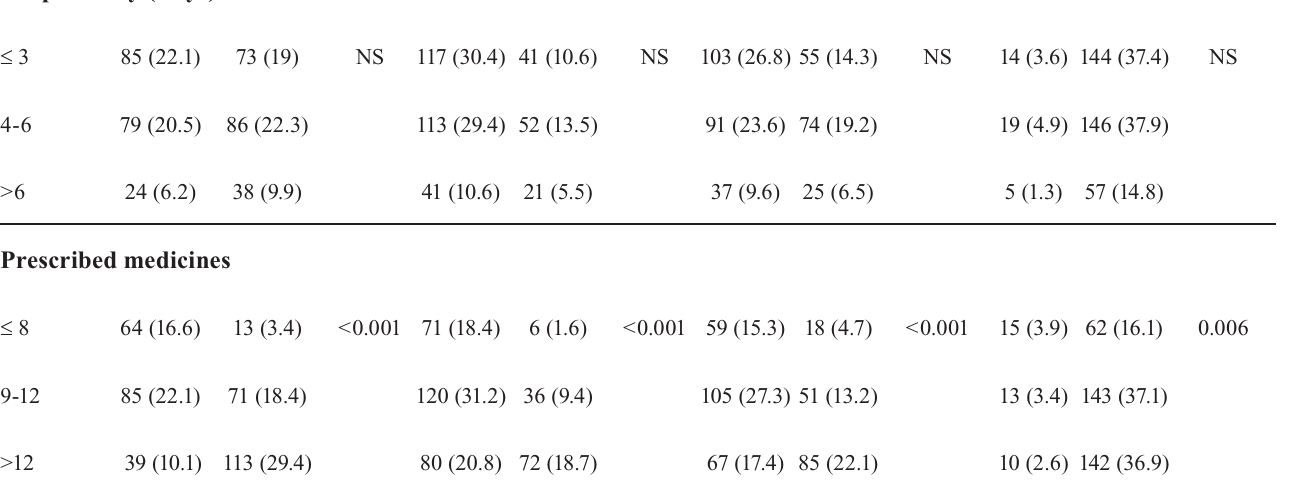
pDDIs = potential drug-drug interactions.